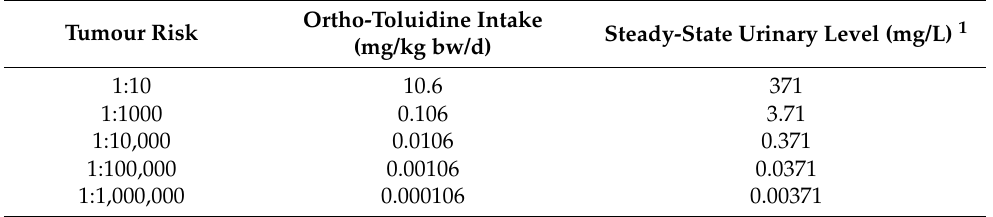
Table 3. Ortho-toluidine linear cancer risk estimations for general population, corresponding to specific lifetime cancer risk, and calculated urinary steady-state